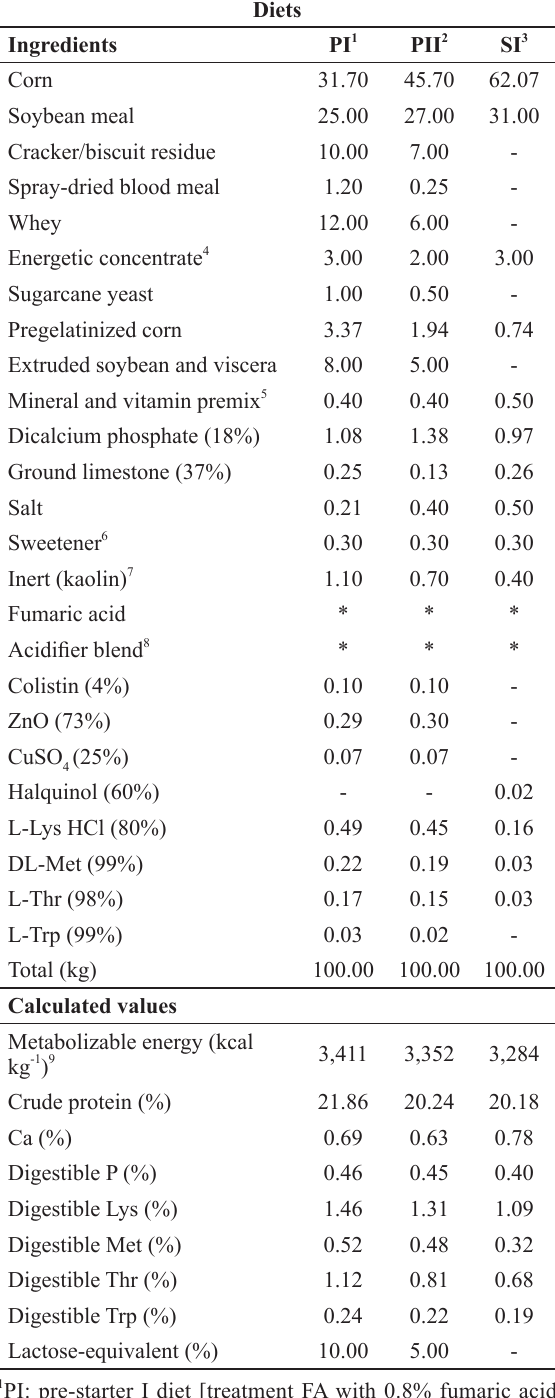
Composition of experimental diets provided to piglets from 21- to